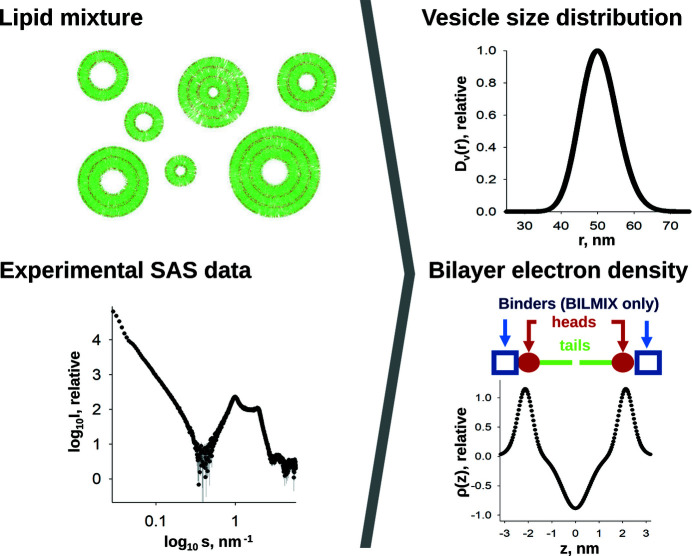

LIPMIX and BILMIX model the size distribution of liposomes [D
v(r)] and their electron-density profiles [ρ(z)], based on experimental scattering data. Positioned above the ρ(z) plot is a schematic depicting the location in the lipid bilayer that is being represented.